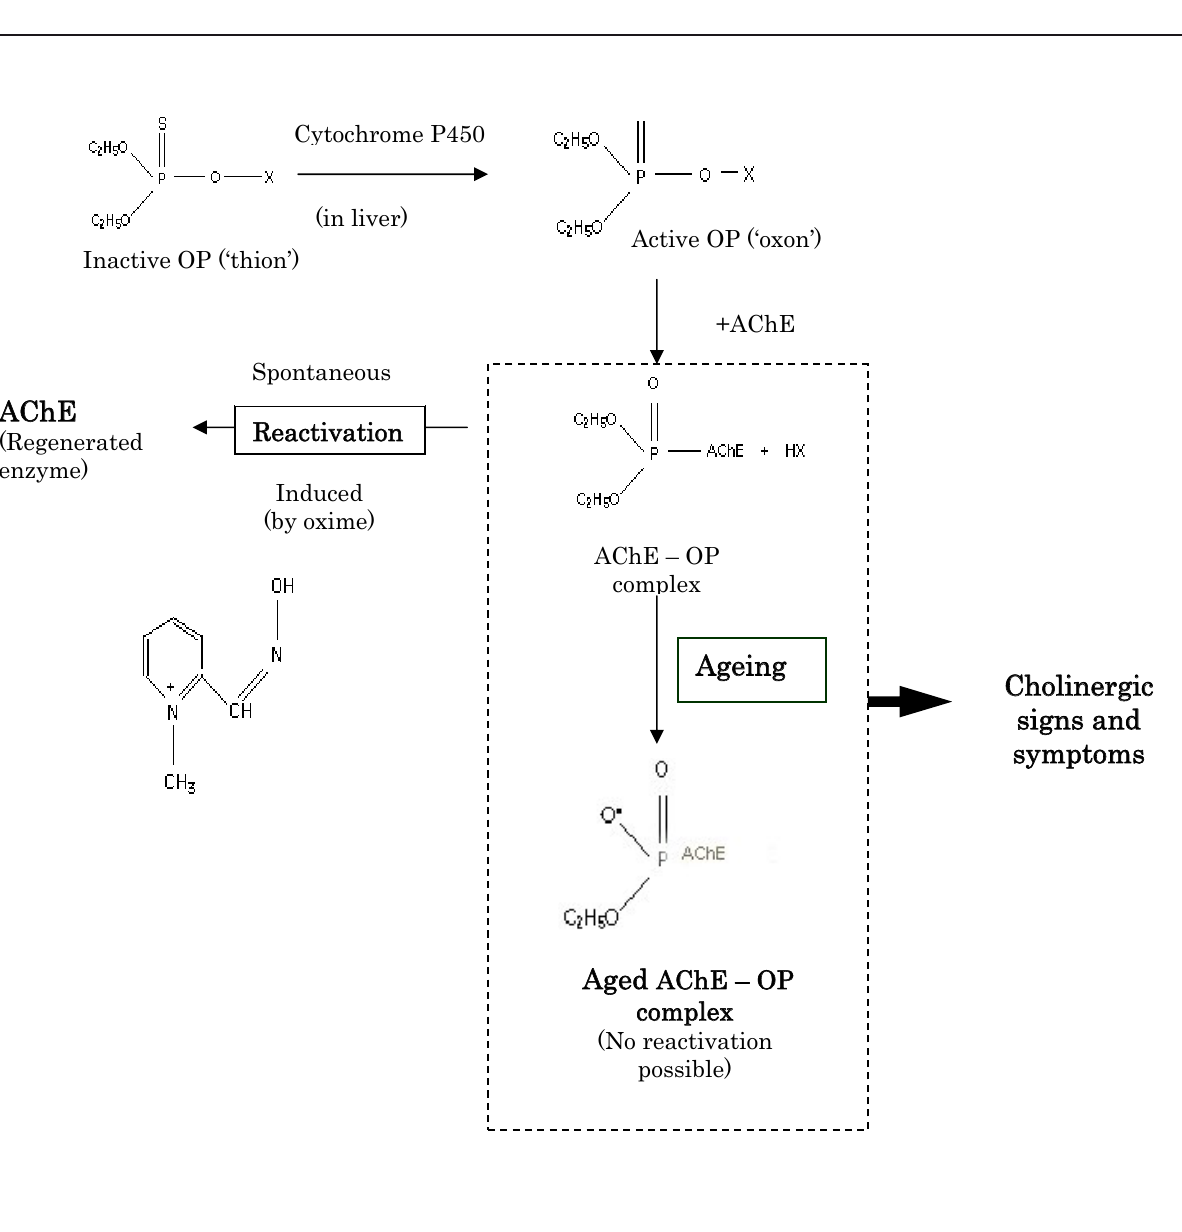
Figure 1. Diagrammatic representation of the possible reactivation & ageing reactions of AChE after inhibition by OP